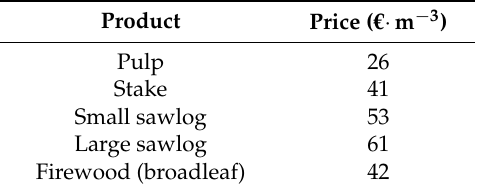
Table A3. Forest product prices (standing) used. Source: Coillte.